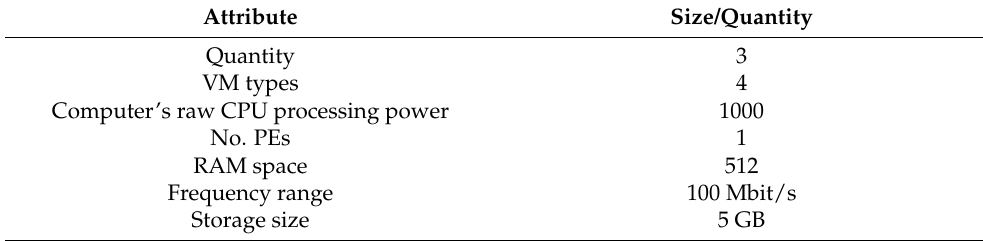
Table 1. VM Attributes.